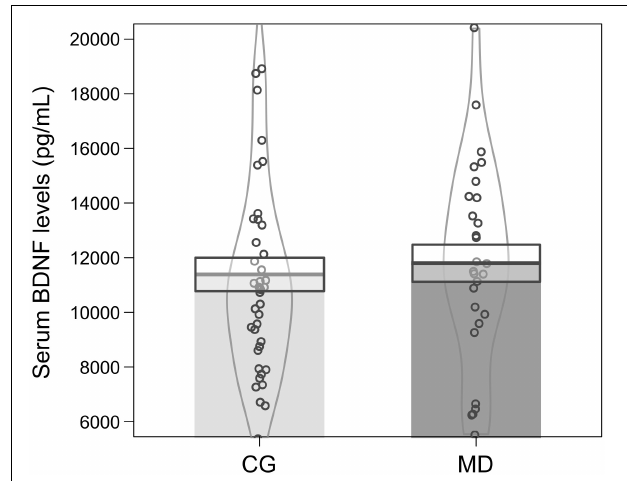
FIGURE 1 | Mean ± standard error of serum BDNF levels (pg/mL) at baseline for patients (MD, dark gray color n = 28) and controls (CG, light gray color n = 41). The curvilinear gray lines represent the density of sample distribution. The circles represent individuals in each group.